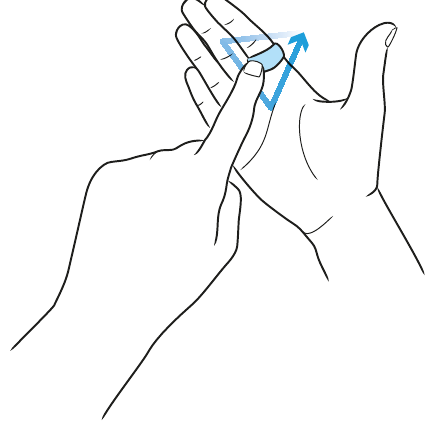
Figure 14. Drawing unistroke gestures above